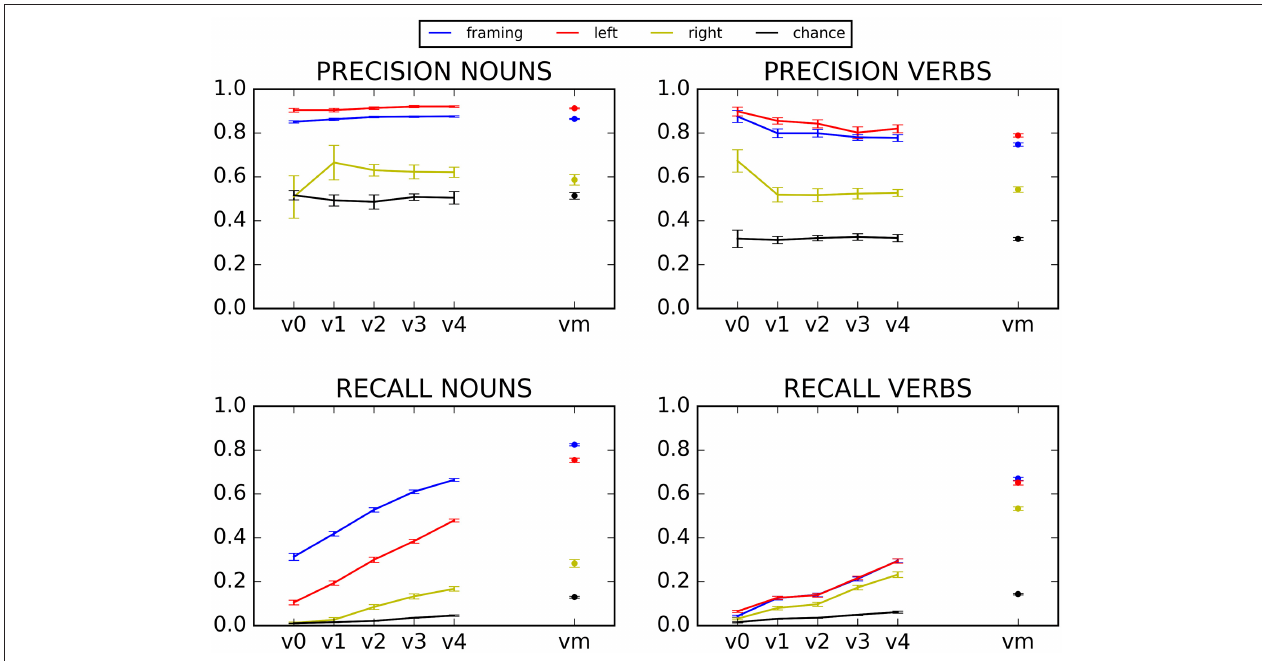
FIGURE 3 | Precision and recall for N and V, for various semantic seed sizes. Error bars represent the standard error of the mean of the ten different mini-corpora.